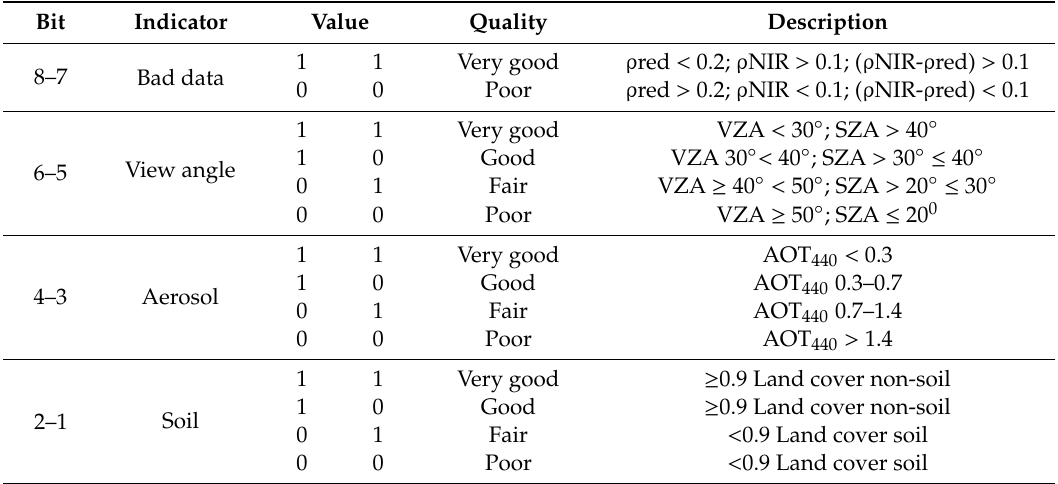
Table 2. Sentinel-3 OTCI quality flags description for bad data, view angle, aerosol, and soil Bit Indicator Value Quality